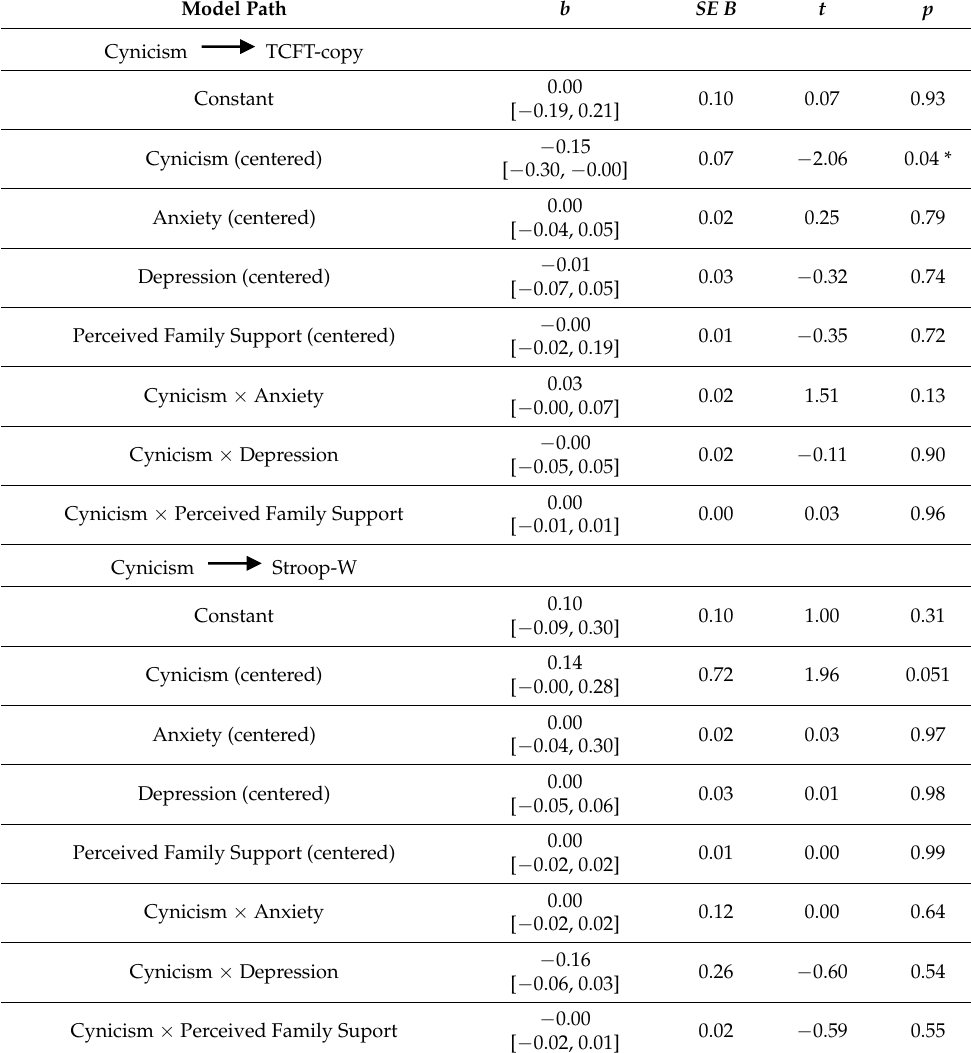
Table A5. Linear models of predictors of cognitive performance ( n = 104).